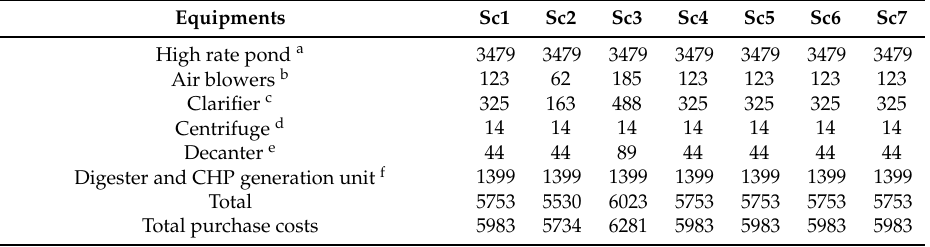
Table 6. Total purchase costs (in k € ) of the major equipment in each of the studied scenarios (Sc).